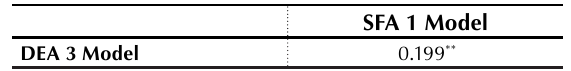
Table 6. Correlation between parametric and non-parametric